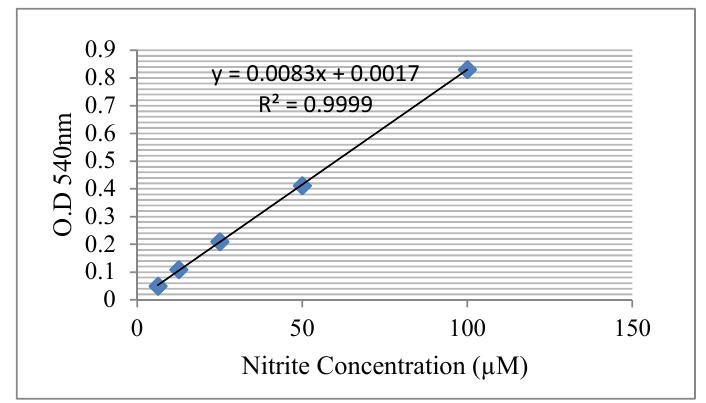
Figure 8. NaNO 2 standard curve used to obtain NO concentration. Table 6. Nitric oxide scavenging activity of synthesized compounds at di ff erent concentrations.